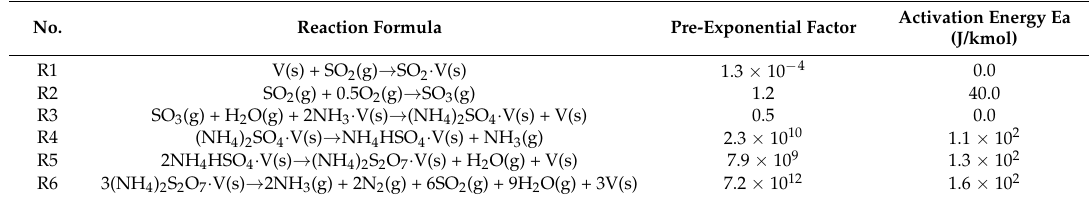
Table 6. Sulfate passivation reaction pathway.